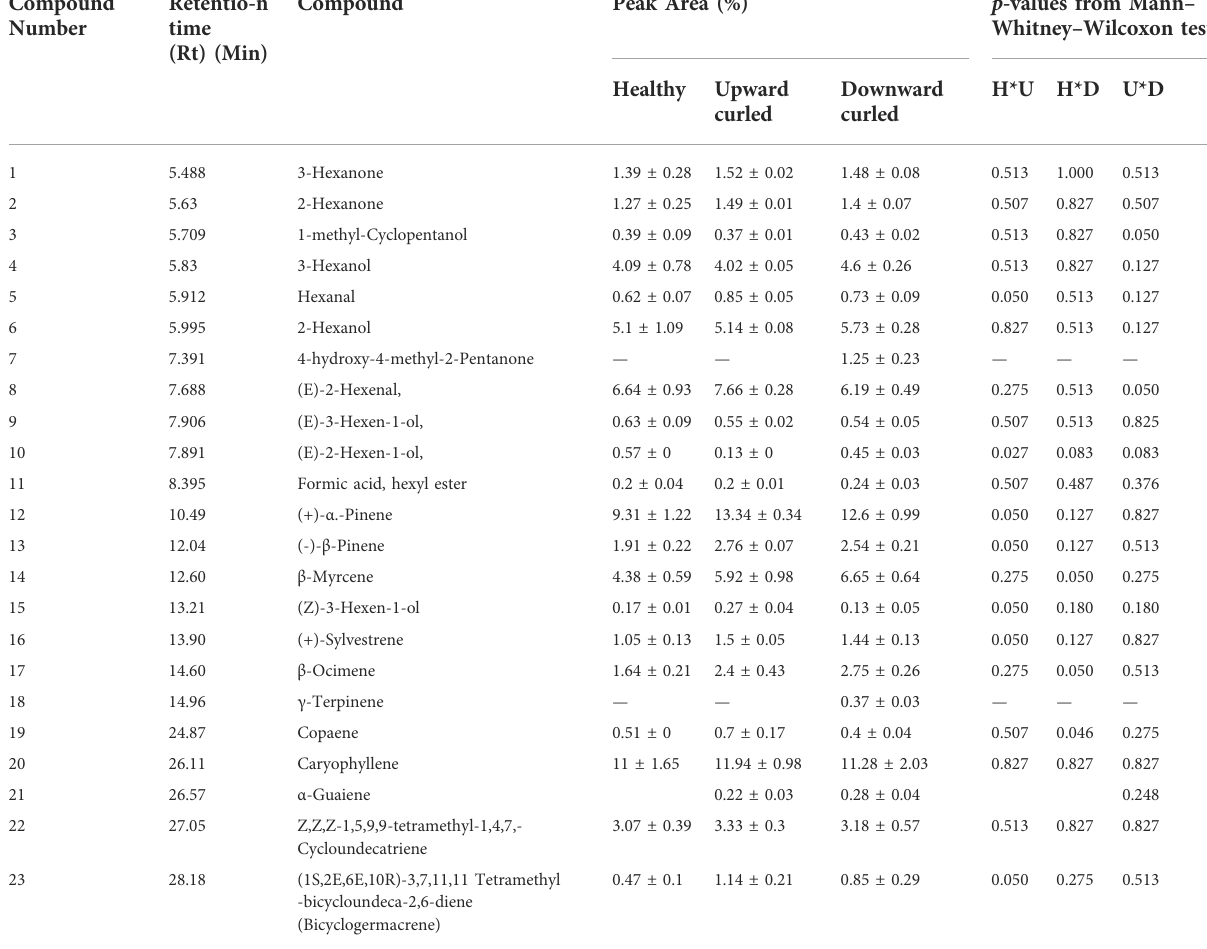
TABLE 1 Comparative analysis of volatile organic compounds (VOC ’ s) from different stages of cotton through GC-MS. Compound